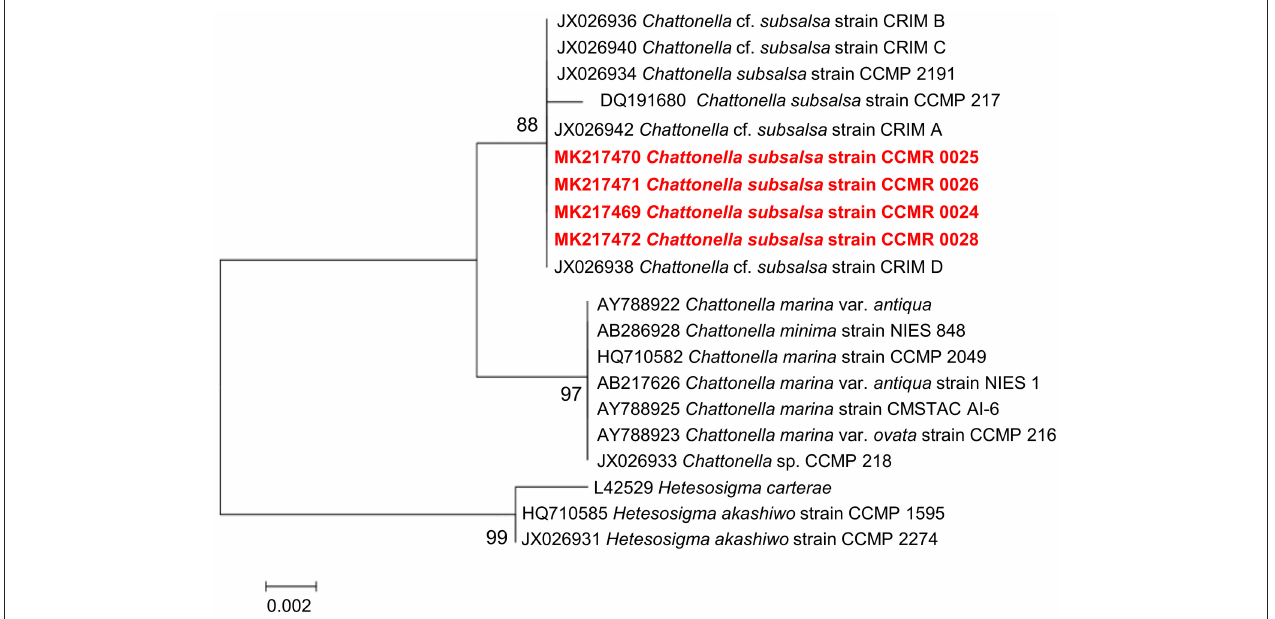
FIGURE 5 | Phylogenetic reconstruction of C. subsalsa strains isolated from Guanabara Bay (red, boldface font) and other raphidophytes based on 18S rDNA sequences. The evolutionary history was inferred by using the Maximum Likelihood method based on the Tamura-Nei model. A discrete Gamma distribution was used to model evolutionary rate differences among sites [5 categories ( + G, parameter = 0.1000)]. The tree is drawn to scale, with branch lengths measured in the number of substitutions per site. The analysis involved 20 nucleotide sequences. All positions containing gaps and missing data were eliminated. There were a total of 699 positions in the final dataset. Evolutionary analyses were conducted in MEGA7.